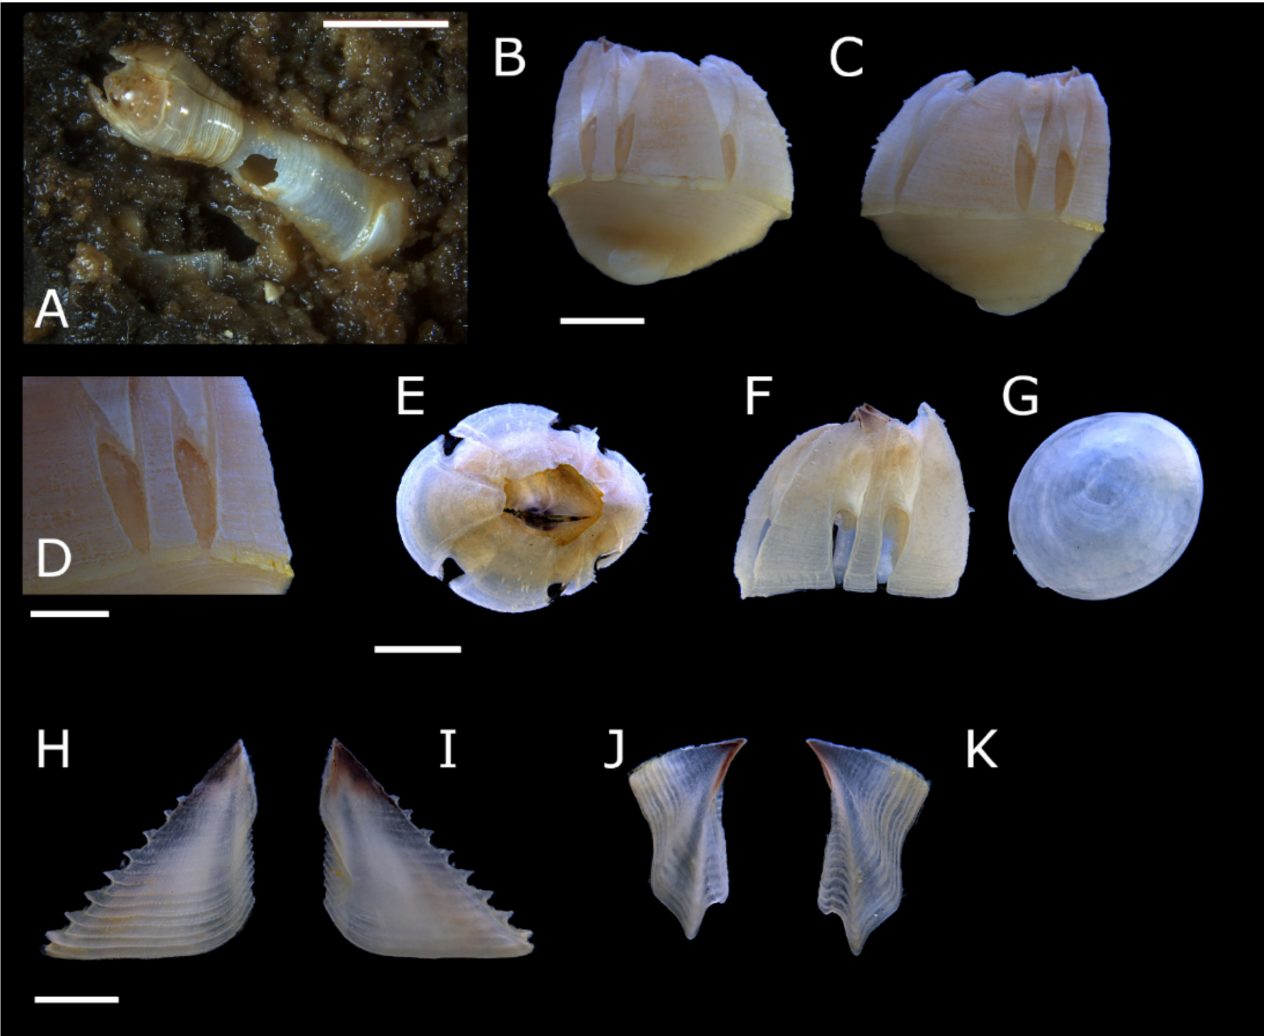
Figure 5. Acasta fenestrata Darwin, 1854 shell plates (A, WAM C66924; B–D WAM C46669; E–J, WAM C55291). ( A ) whole, enormously elongate specimen still embedded in host; ( B,C ) left and right lateral views of whole specimen; ( D ) close up of fenestrae on right side; ( E,F ) ventral and lateral view of specimen (basis removed); ( G ) internal view of basis; ( H , I ) external and internal view of right scutum; ( J , K ) internal and external view of right tergum. Scale bars: A = 5 mm; B, C, E–G = 2 mm; H–K = 1